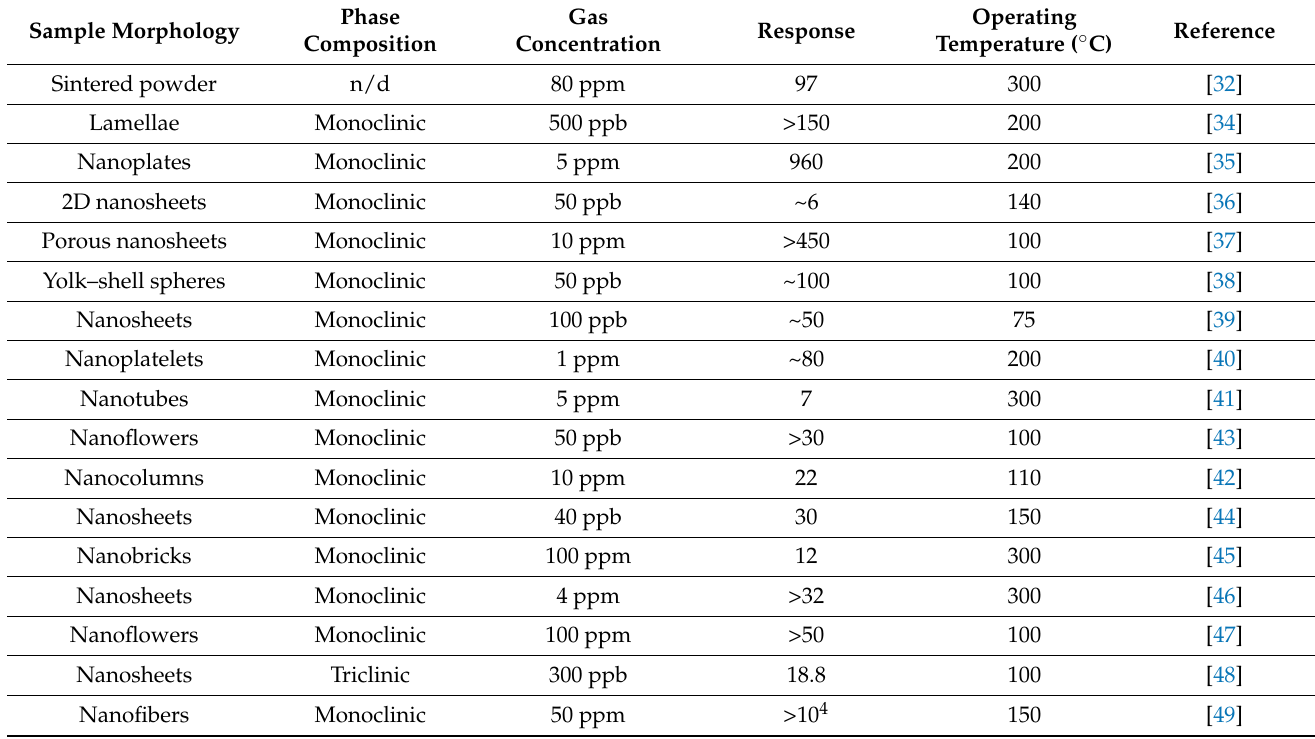
Table 1. Summary of the main features of the WO 3 -based NO 2 sensors described in Section